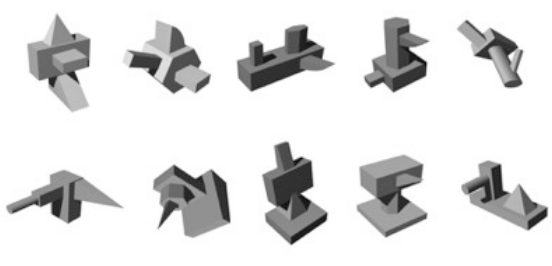
Figure 5 – The ten grey-scale 3-D rendered stimuli that were used in the experiment. For each stimulus shown an additional 5 were created by obtaining images of the same object rotated 60, 120, 180, 240 and 300 degrees about the image plane.